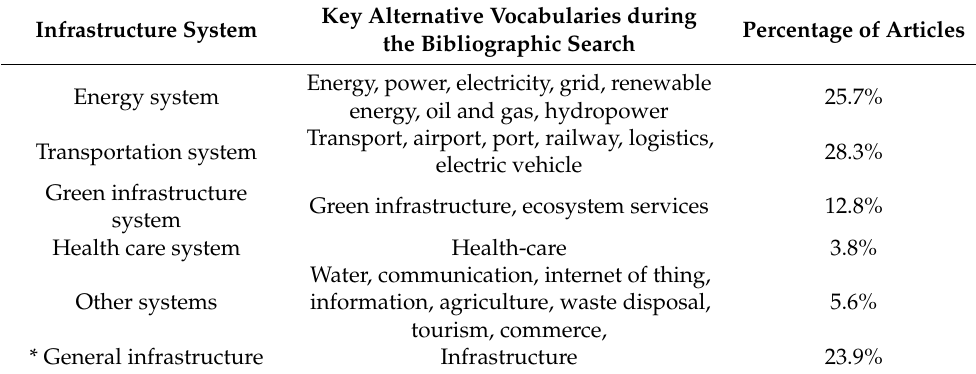
Table 4. Percentage of articles falling in different infrastructure systems.